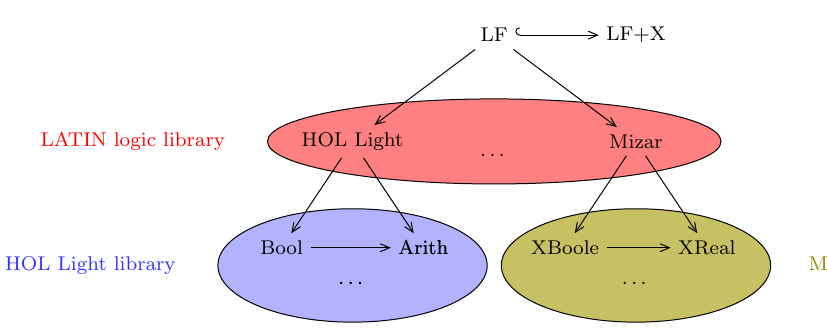
Fig. 8. Representing Libraries in OMDoc /